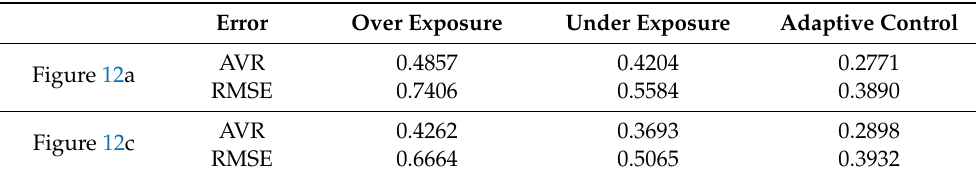
Table 2. Center extraction errors of different stripe images (pixels).